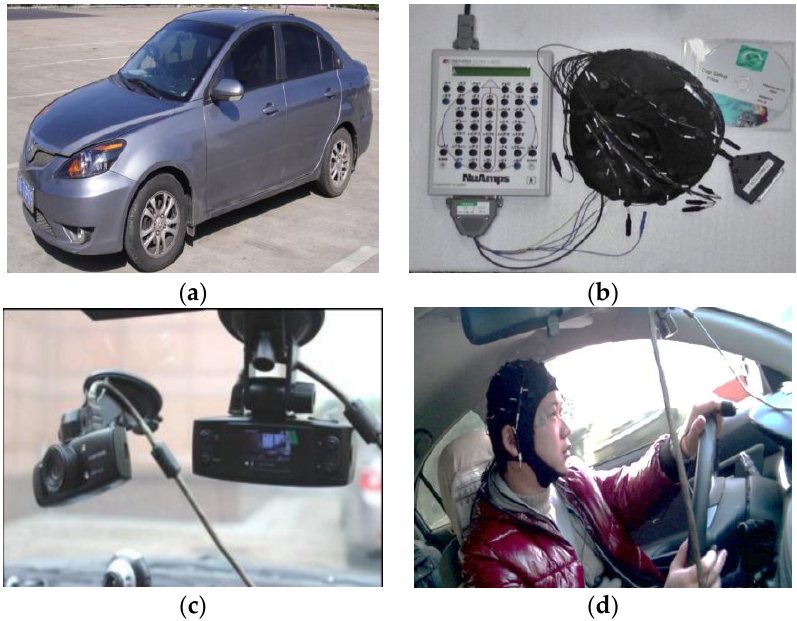
Figure 1. The Apparatus of on-road experimental system. ( a ) The test vehicle; ( b ) NeuroScan4.5 acquisition system; ( c ) Monitor video camera system; ( d ) Overall sketch of the apparatus system.